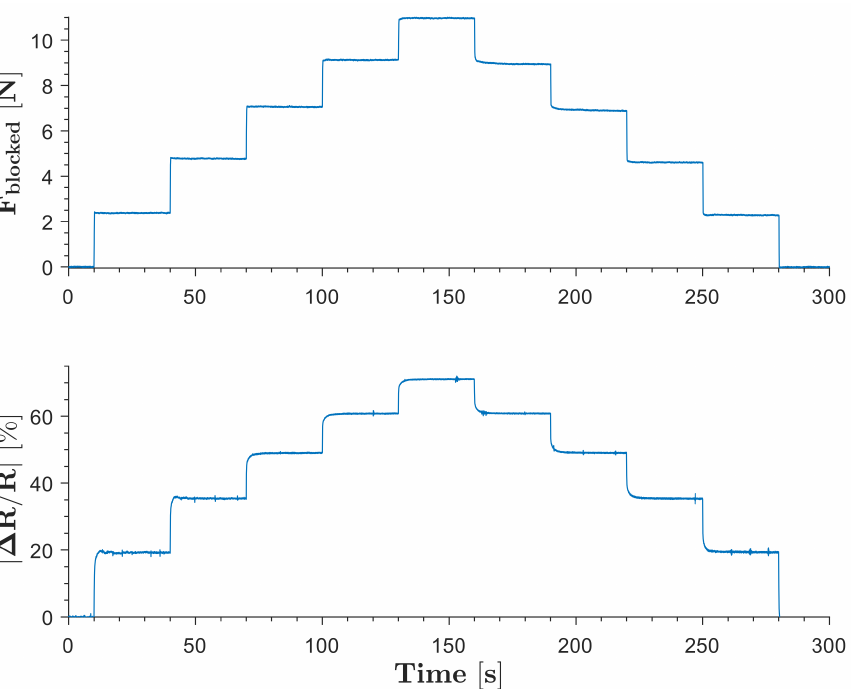
Figure 4. Blocked forces of SoHapS under various pressure inputs ranging from 0 to 250 kPa with 50 kPa steps. The primary axis shows the blocked force, and the secondary axis shows the change in resistance as the soft sensor